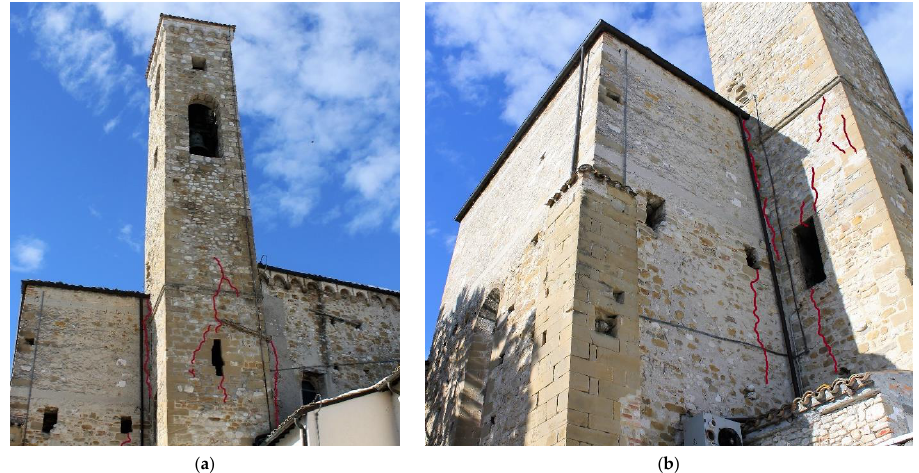
Figure 18. Damages on the stem of the belltower ( a , b ): the case of the St. Francis church in Campli (C23). The observed crack pattern has been highlighted in red.